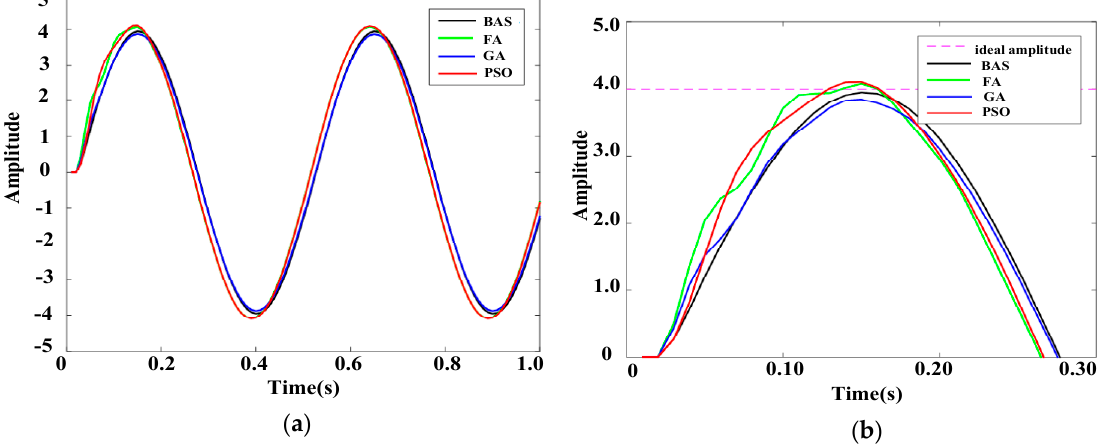
Figure 11. Response curves of the sinusoidal signal whose amplitude is 4. ( a ) Whole response curves. ( b ) Local amplification curves.